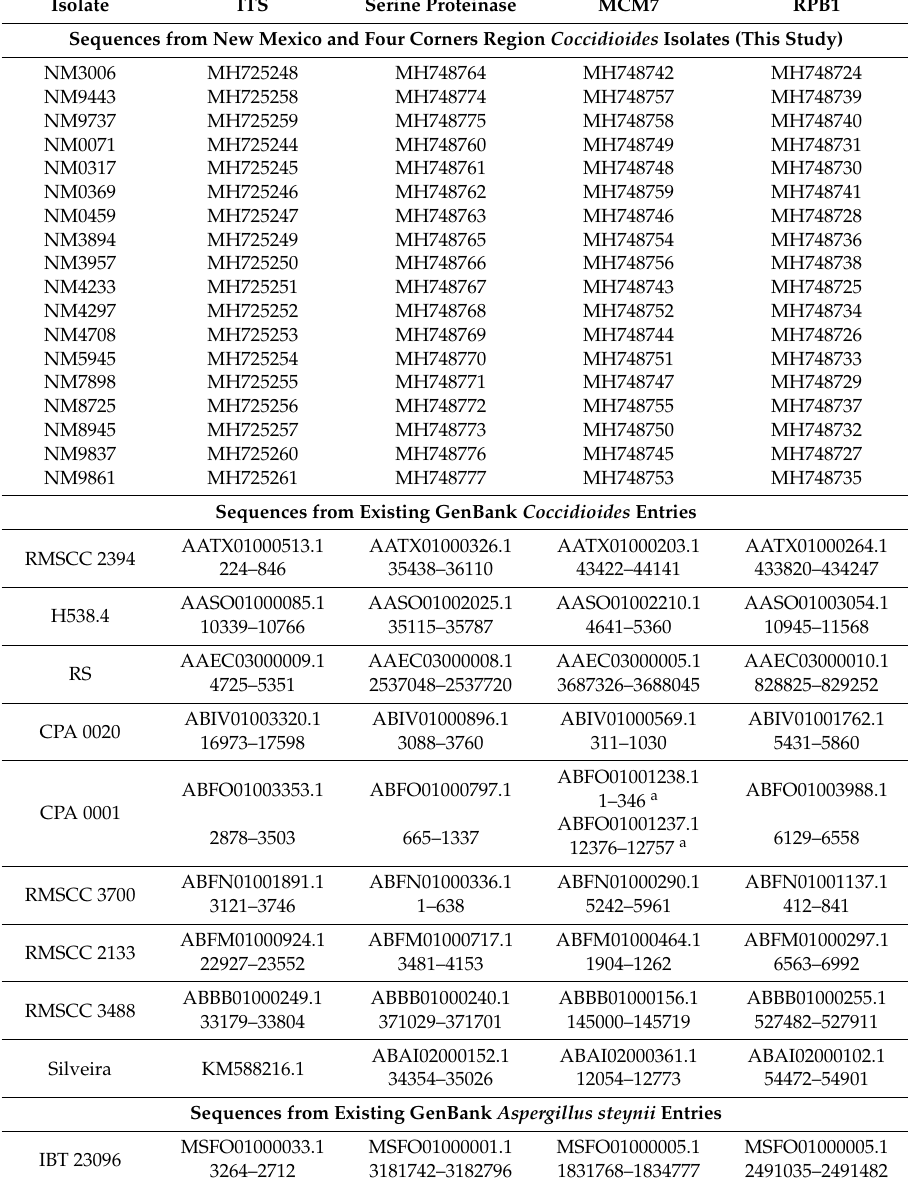
Table 3. GenBank accession numbers for sequences employed in phylogenetic